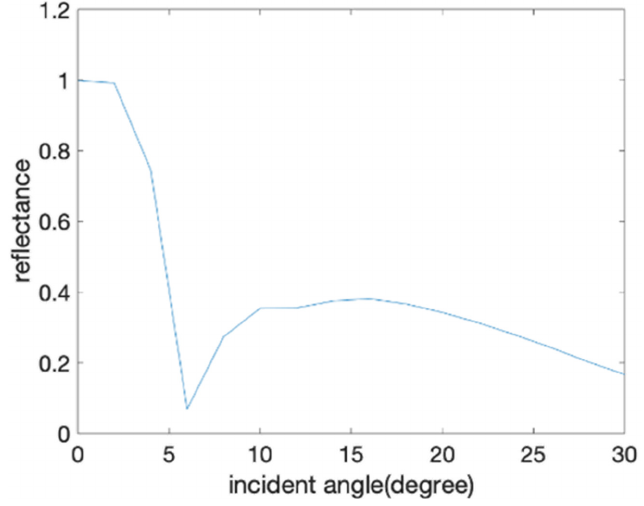
Figure 7. Reflection of Si nanoholes as a function of incident angle. Here, the height H = 200 nm, D x = 0.485 µm, D y = 0.43 µm, and the lattice period P is 600 nm.